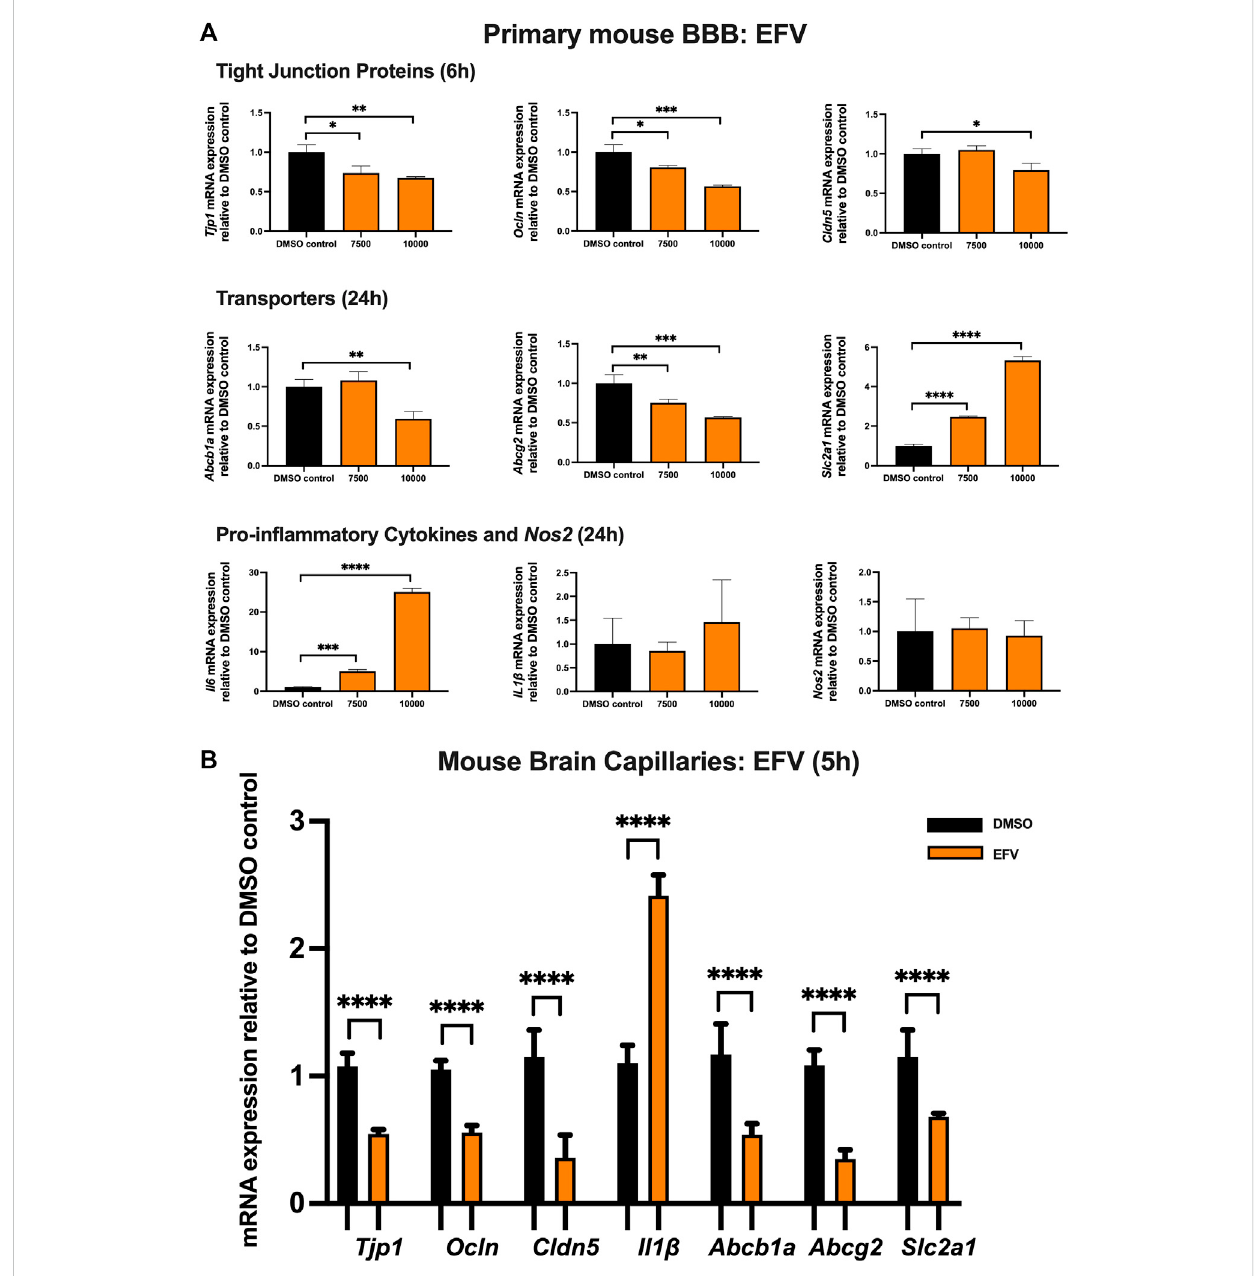
FIGURE 2 mRNA expression of TJ proteins, transporters, proin fl ammatory cytokines and Nos2 in primary cultures of mouse brain microvascular endothelial cells exposed to EFV (7,500, 10,000 ng/mL) and vehicle (DMSO) control for 6 or 24 h and in isolated mouse brain capillaries exposed to EFV (10,000 ng/ mL) and vehicle (DMSO) control for 5 h (A) mRNA expression of Tjp1, Ocln, Cldn5, Abcb1a, Abcg2, Slc2a1, Il6, Il1 β and Nos2 in primary cultures of mouse brain microvascular endothelial cells exposed to EFV relative to vehicle (DMSO) control was assessed by qPCR. Results are presented as mean relative mRNA expression ±SEM normalized to the housekeeping mouse cyclophilin B gene from n = 4 independent experiments. (B) mRNA expression of Tjp1, Ocln, Cldn5, Abcb1a, Abcg2, Slc2a1 and Il1 β in isolated mouse brain capillaries treated for 5 h with EFV (10,000 ng/mL) relative to vehicle (DMSO) was assessed by qPCR. Results are presented as mean relative mRNA expression ±SEM normalized to the housekeeping mouse cyclophilin B gene from n = 3 independent experiments, where each experiment contained pooled brain tissues from 6 animals per group. One-way ANOVA with Bonferroni ’ s post-hoc test (A) , unpaired two-tailed Student ’ s t -test (B) : *, p < 0.05; **, p < 0.01; ***, p < 0.001; ****, p <